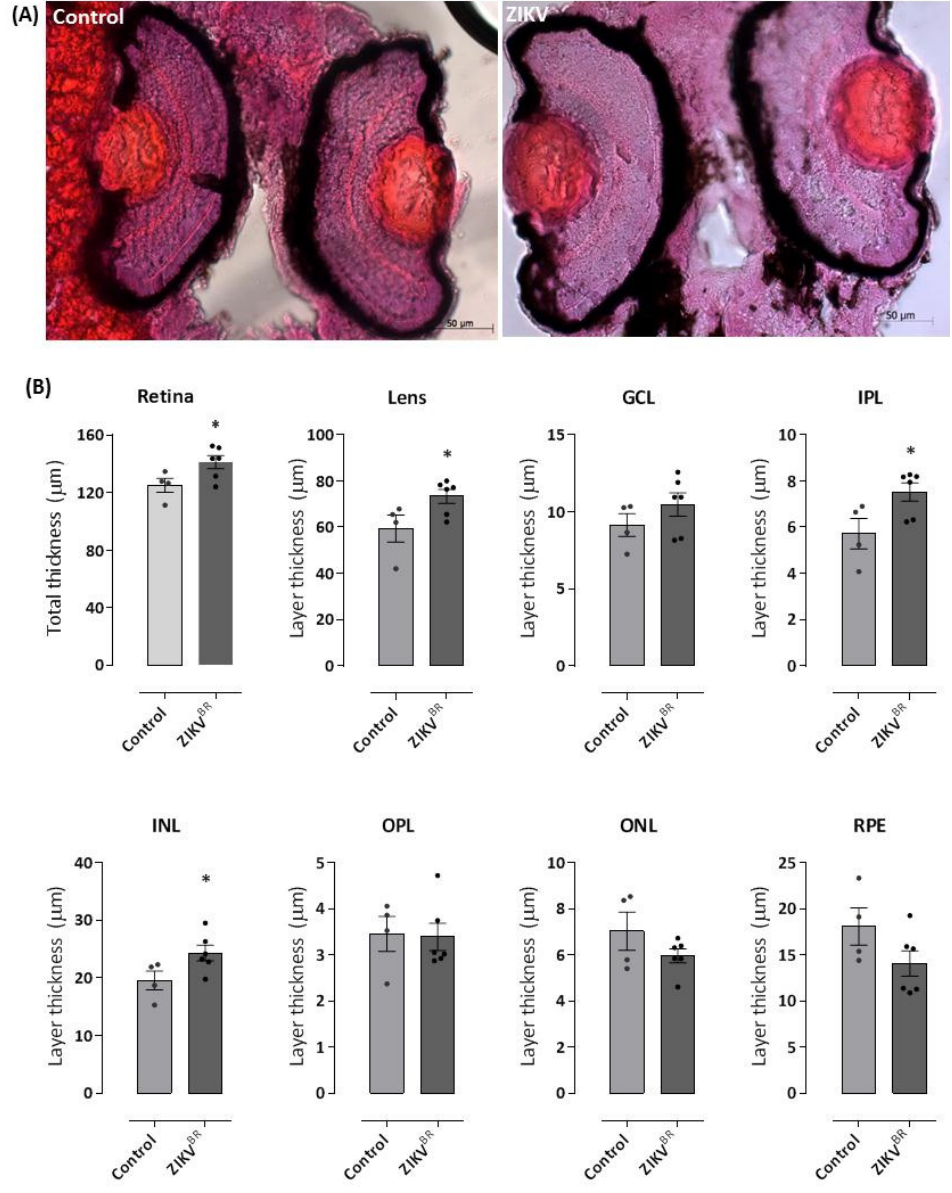
Figure 3. ZIKV causes an increase in the thickness of the zebrafish retina, especially in the lens and inner nuclear layer. The 96 hpf larvae infected with ZIKV BR at 0 hpf or control group were fixed, dehydrated and rehydrated, incubated in 30% sucrose, and were mounted in OCT. Then, 18 µ m-thick cryosections were stained with H&E. The images obtained under an optical microscope show an increased retinal layer thickness in ZIKV-infected larvae ( A , B ), which is most evident in the lens region. Red dots in the eyes of the control animals do not represent any morphological changes or developmental malformations. All measures were made in ImageJ software. GCL = ganglion cell layer; INL = inner nuclear layer; ONL = outer nuclear layer; IPL = inner plexiform layer; OPL = outer plexiform layer; RPE = retinal pigment epithelium. Each bar represents the mean ± SEM. * p < 0.05 compared with the negative control